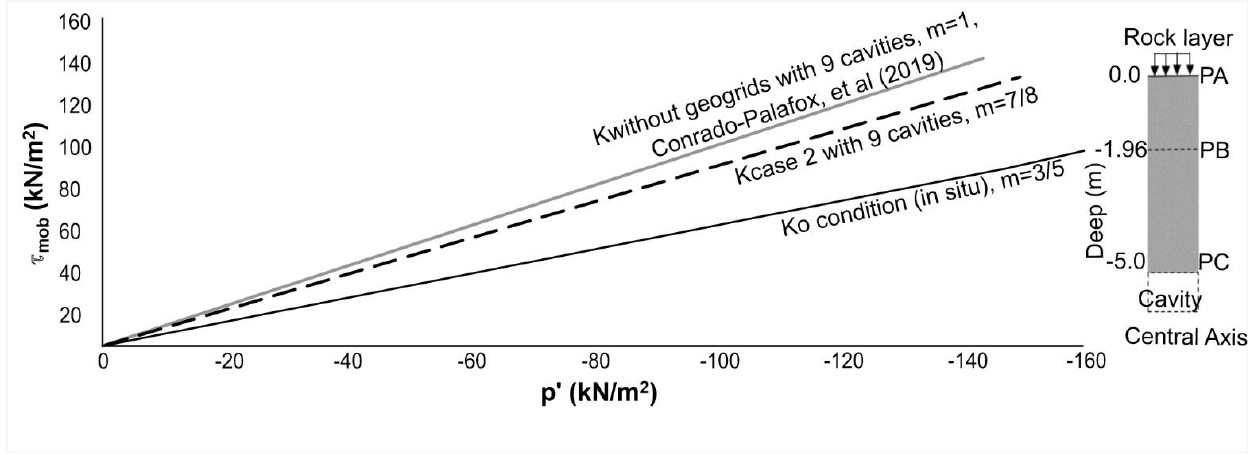
Figure 14. Variation in the in-situ stresses ( K 0 ) in the rock layer, for the Case 2 (geogrids in N 1 and N 2 depths) and without geogrids [3] in the phase with 9 cavities in the ground.